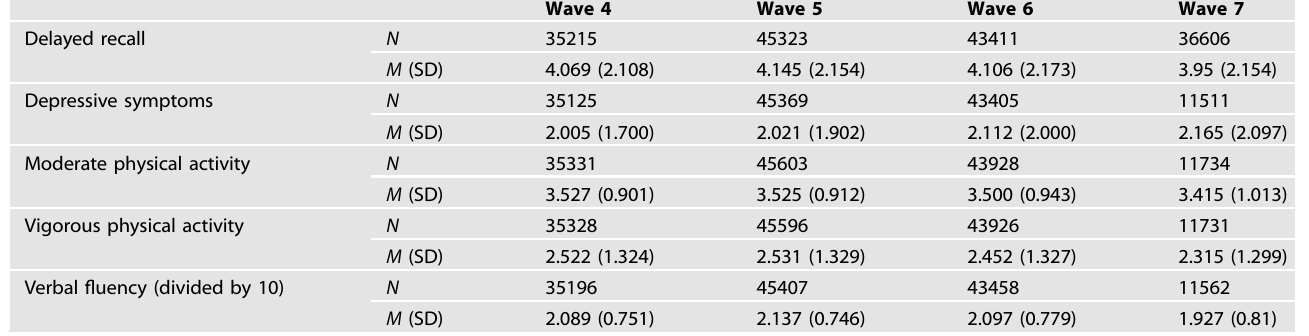
Table 2. Descriptive statistics of study measures at each